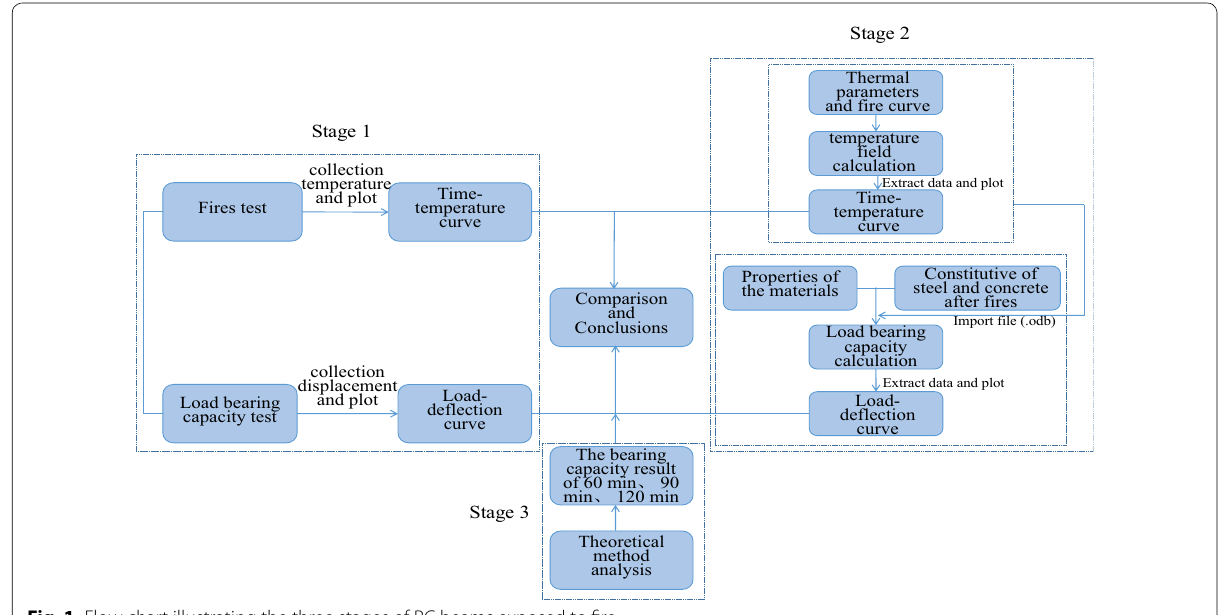
Fig. 1 Flow chart illustrating the three stages of RC beams exposed to fire